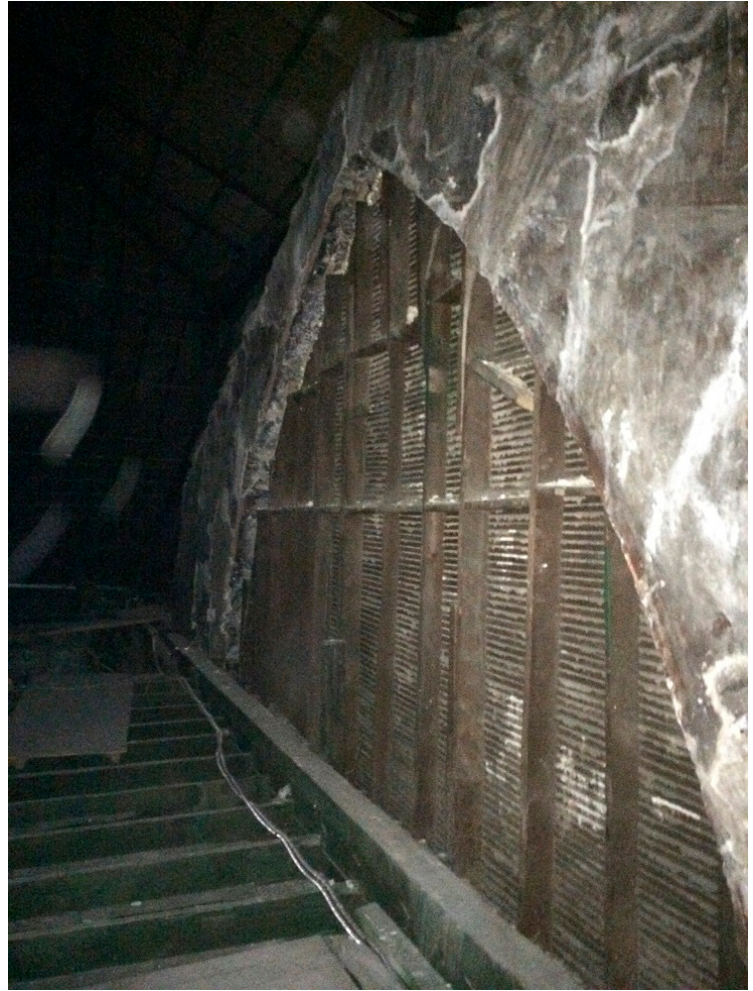
Figure 7. Pera, the church of St. Paul, the upper part of the triumphal arch seen from the attic, fot. H. Sercan Sa ğ lam (2017).